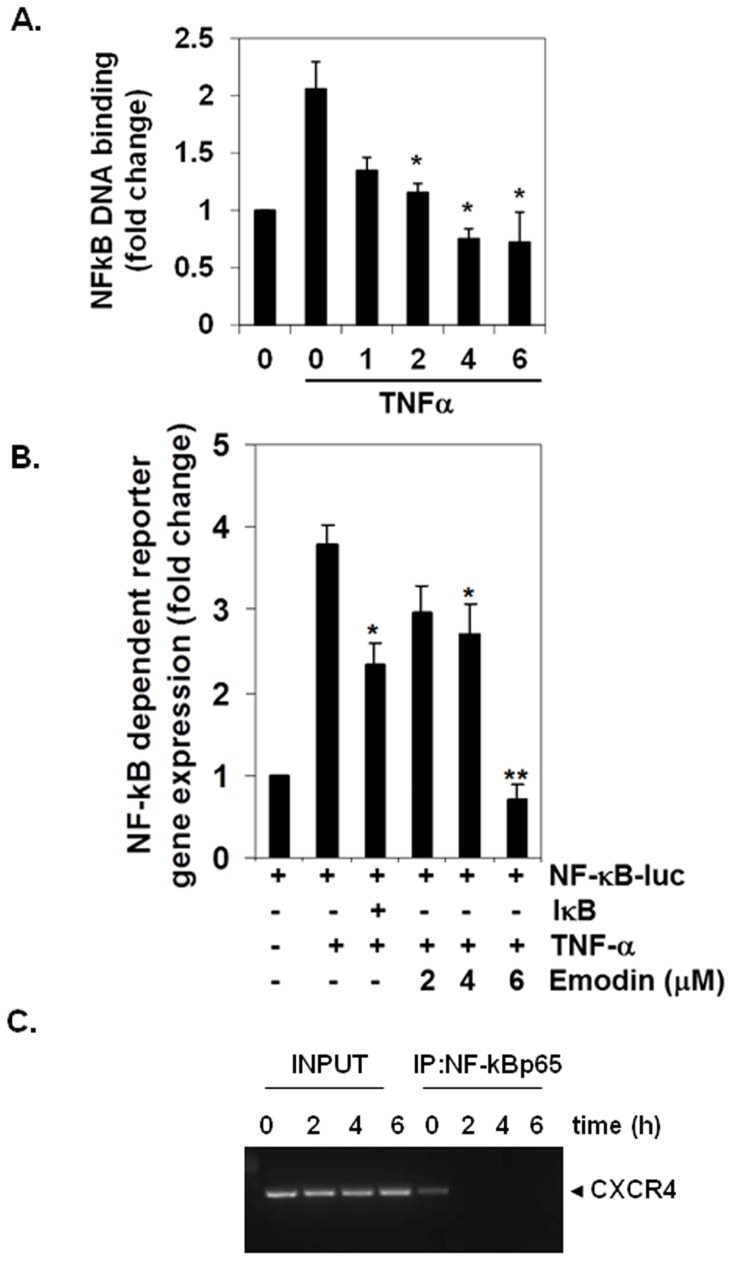
Emodin inhibits TNF-α inducible NF-κB activation in HepG2 cells.A, HepG2 cells were incubated with 50 µM emodin for the indicated time points and then stimulated with TNF-α (1 nM) for 24 h. The nuclear extracts were assayed for NF-κB activation by TransAM p65 transcription factor assay kit. Bars indicate standard error. * indicates p value <0.05. B, HepG2 cells were transiently transfected with an NF-κB luciferase plasmid and co-transfected with β-galactosidase and then treated with 50 µM emodin for the indicated time points and then stimulated with TNF-α (1 nM) for 24 h. Cell supernatants were thereafter collected and assayed for luciferase activity as described in Materials and Methods. Representative results of two independent experiments are shown. Results are expressed as fold activity over the activity of the vector control. Bars indicate standard error. * indicates p value <0.05; ** indicates p value <0.001. C, Emodin inhibits binding of NF-κB to the CXCR4 promoter. Hep3B cells were treated with 50 µM emodin for indicated time intervals and the proteins were crosslinked with DNA by formaldehyde and then subjected to ChIP assay using an anti-p65 antibody with the CXCR4 primer. Reaction products were resolved by electrophoresis.